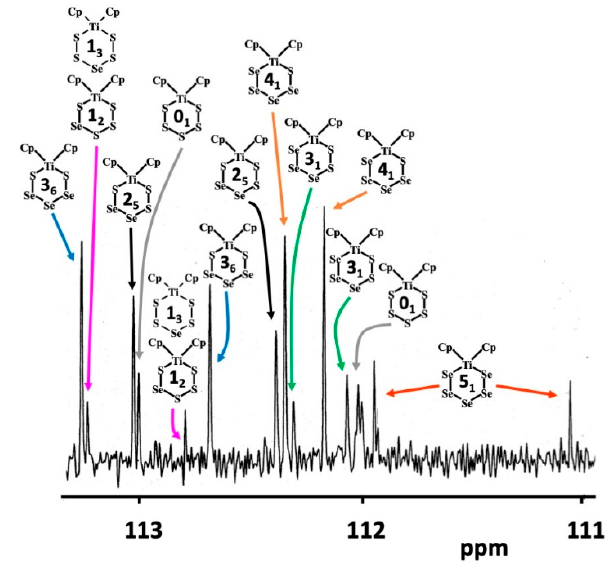
Figure 4. 13 C-NMR spectrum of phase D in CS 2 .